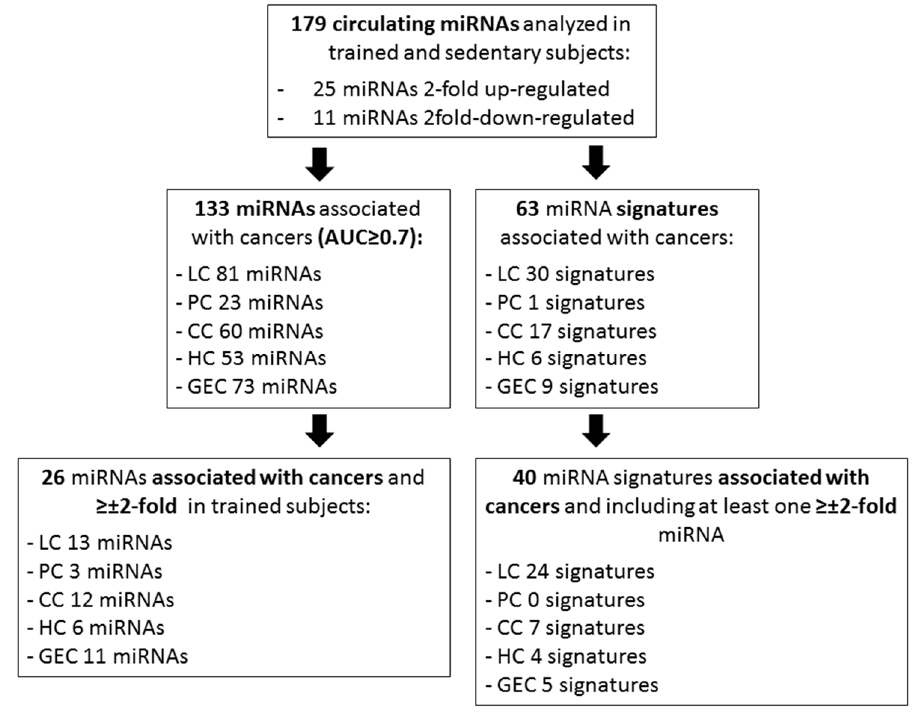
Figure 1. Description of selection strategy of cancer associated miRNAs and signatures. The expression profile of a panel of 179 miRNAs (Table S1), the most abundant in circulation, were analyzed in plasma of two cohorts: sedentary and trained cohorts. Thirty-six miRNAs were significantly modulated by PA: 25 miRNAs were ≥ 2-fold upreg- ulated and 11 were ≥ 2-fold downregulated (Table 1). Table 1. Fold-Change analyzed miRNAs significantly ≥ 2-fold up- or downregulated in trained subjects compared to sedentary subject ( p -value < 0.05).